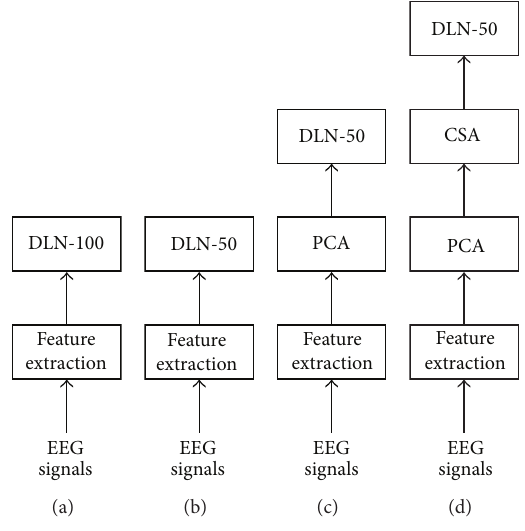
Figure 12: Overview of four experiment